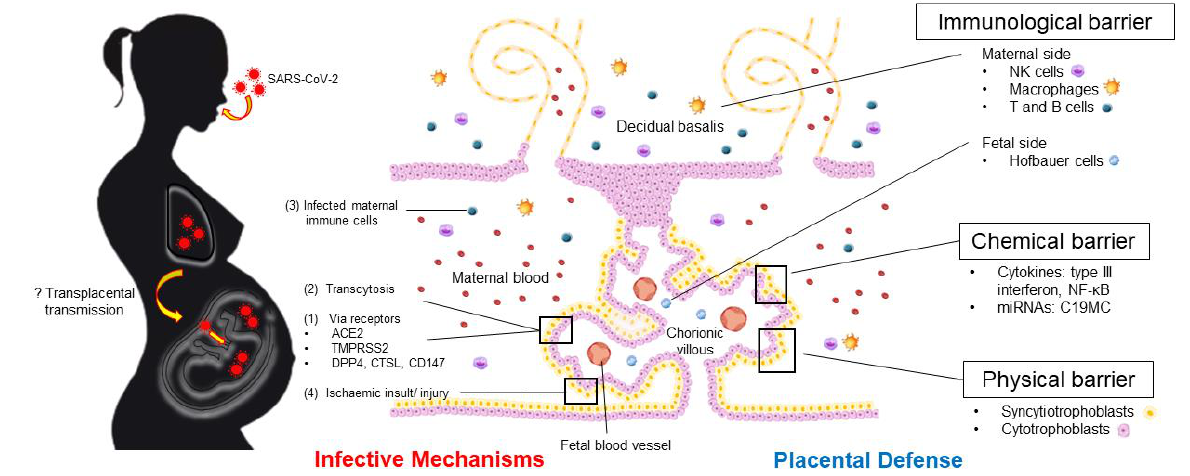
Figure 1. Plausible SARS-CoV-2 transplacental infective mechanisms and the various placental de- fense to prevent mother-to-fetal transmission. Abbreviations: ACE2: angiotensin converting enzyme 2; C19MC: chromosome 19 microRNA cluster; CTSL: cathepsin-L; DPP4: dipeptidylpeptidase-4; miRNAs: microRNAs; NK: natural killer; TMPRSS2: transmembrane serine protease.